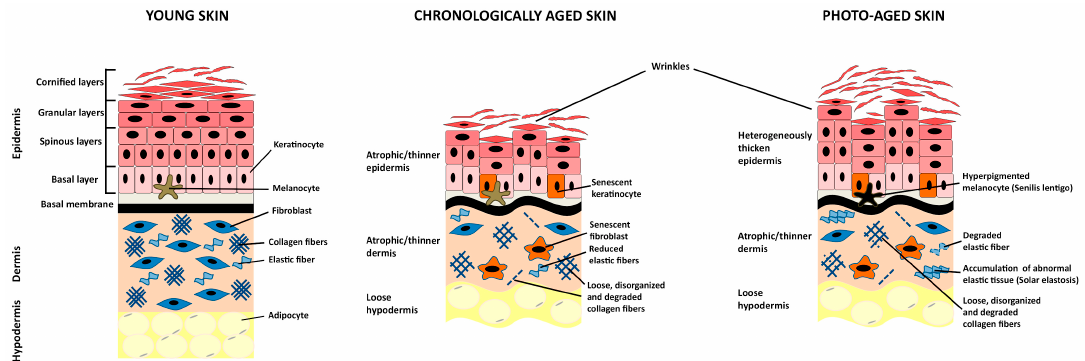
Figure 1. Morphological features of young, chronologically- and photo-aged skin. Schematic organization of the young, chronologically aged or photo-aged skin tissue. Human skin is constituted by three tissue layers: epidermis, dermis, and hypodermis. The epidermis is a stratified epithelium composed of keratinocytes organized into four major layers (basal, spinous, granular, and cornified layers) at progressive differentiation stages including melanocytes. The dermis is populated by fibroblasts embedded by the components of the extracellular matrix made of collagen, elastic fibers, glycoproteins, and proteoglycans. Fibroblasts are the main producers of the extracellular matrix components. The hypodermis is mainly populated by adipocytes. Morphological changes occurring with age are indicated in chronologically- and photo-aged